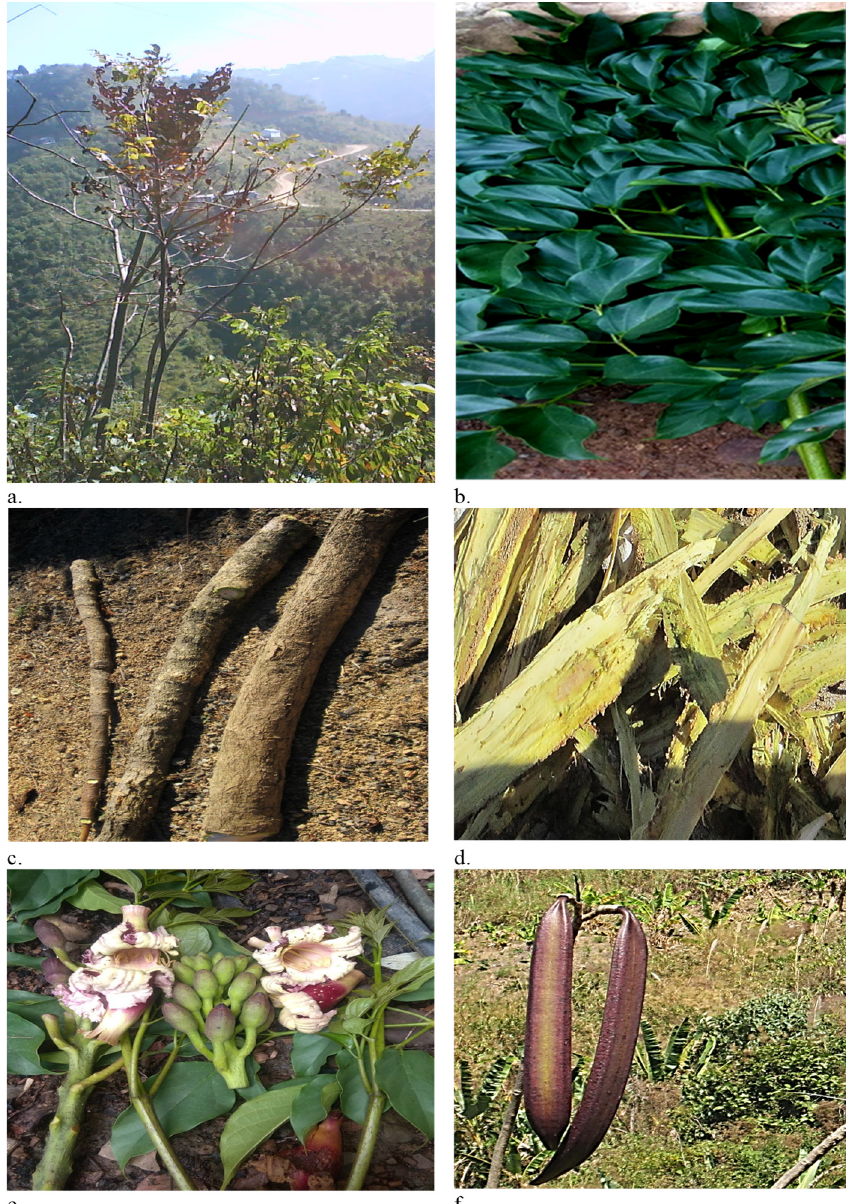
Figure 1. Oroxylum indicum : ( a ): whole tree; ( b ): leaves; ( c ): stem; ( d ): stem bark; ( e ): flowers; ( f ): fruits.